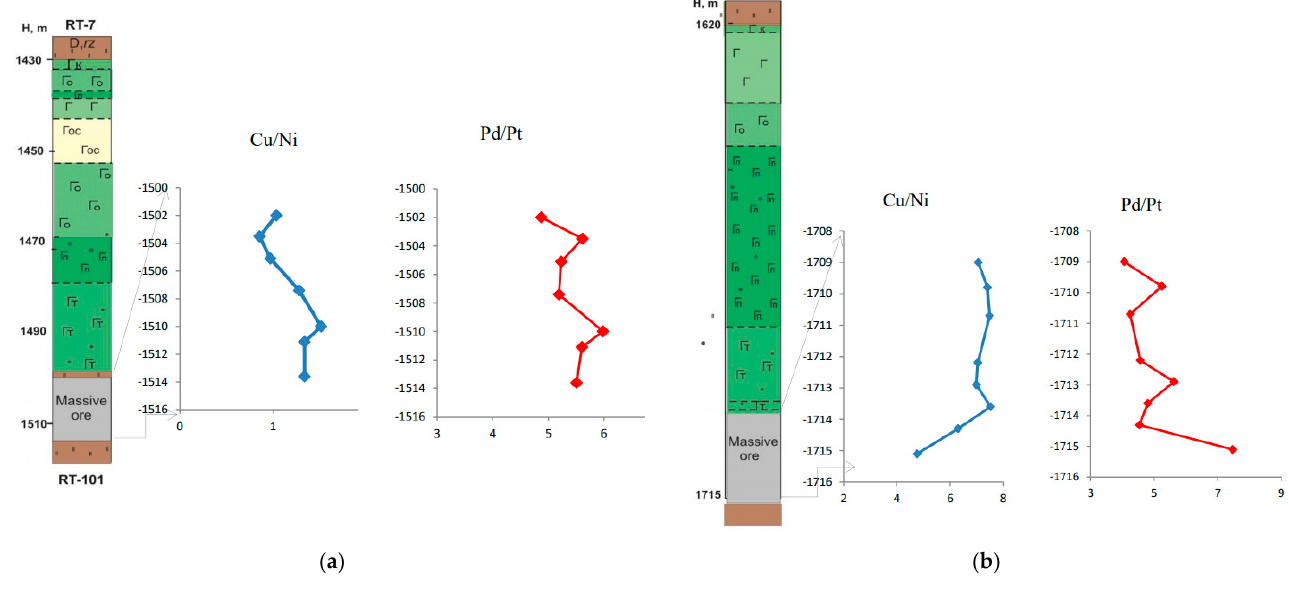
Figure 12. Intrusive structure and Cu/Ni, Pd/Pt distribution in massive ore on the borehole RT-7 (C-3 orebody) and